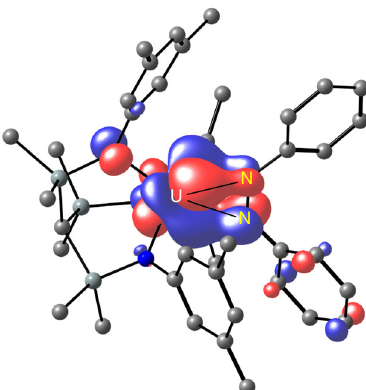
Fig. 9 SOMO orbital of the [U(Ts Xy )( κ 2 -PhNNPh)] intermediate int-C . This shows the δ -type uranium-azobenzene bonding interaction involving a π * azobenzene orbital interacting with a uranium 5 f orbital of general setting m = 2 type parentage. Hydrogen atoms are omitted for l